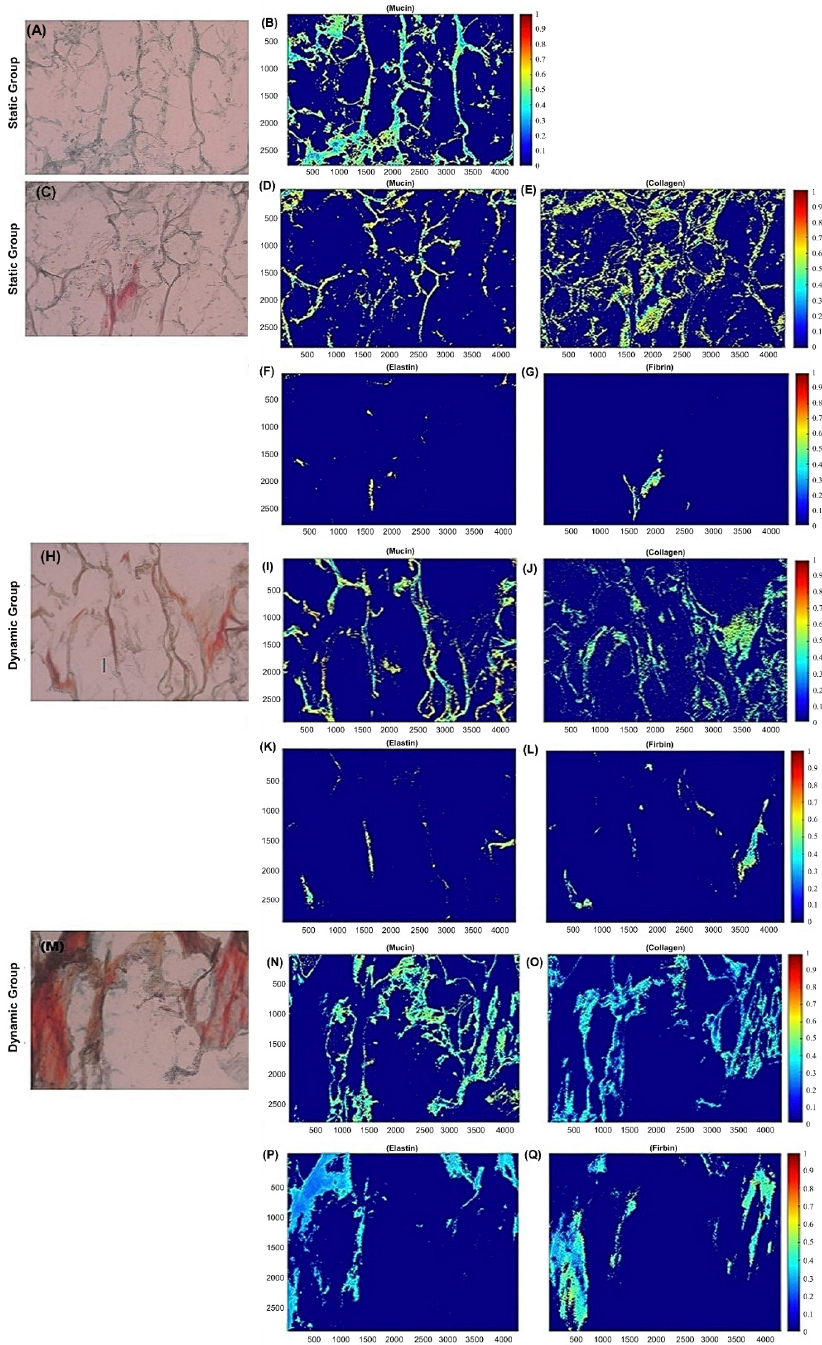
Figure 2. ECM quantification of static and dynamic PSIS valves. ( A , C ) Static PSIS valves were assessed for ECM quantification via spatial intensity maps ( B , D – G ). Spatial intensity maps for these static PSIS valves at a depth of ( A ) 16 µ m and ( C ) 304 µ m were computed. At the outer surface of the PSIS valve, there was ( B ) 21% mucins present with no other ECM components. At a deeper depth, closer to the inner surface of the PSIS valve, there was a presence of ( D ) 9% mucins, ( E ) 20% collagen, ( F ) 0.6% elastin and ( G ) 1% fibrin. ( H , M ) Dynamic PSIS valves were also assessed for ECM quantification via spatial intensity maps ( I – L , N – Q ). Spatial intensity maps for these dynamic PSIS vales at a depth of ( H ) 16 µ m and ( M ) 304 µ m were computed. At the outer surface of the PSIS valve, there was ( I ) 14% mucins, ( J ) 16% collagen, ( K ) 1% elastin and ( L ) 4% fibrin present. At a larger depth, closer to the inner surface of the PSIS valve, there was a presence of ( N ) 21% mucins, ( O ) 16% collagen, ( P ) 9% elastin and ( Q ) 11% fibrin. Magnification 50 ×